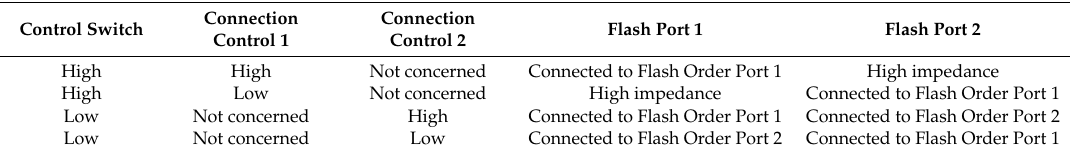
Table 1. Connection relationship for flash ports.